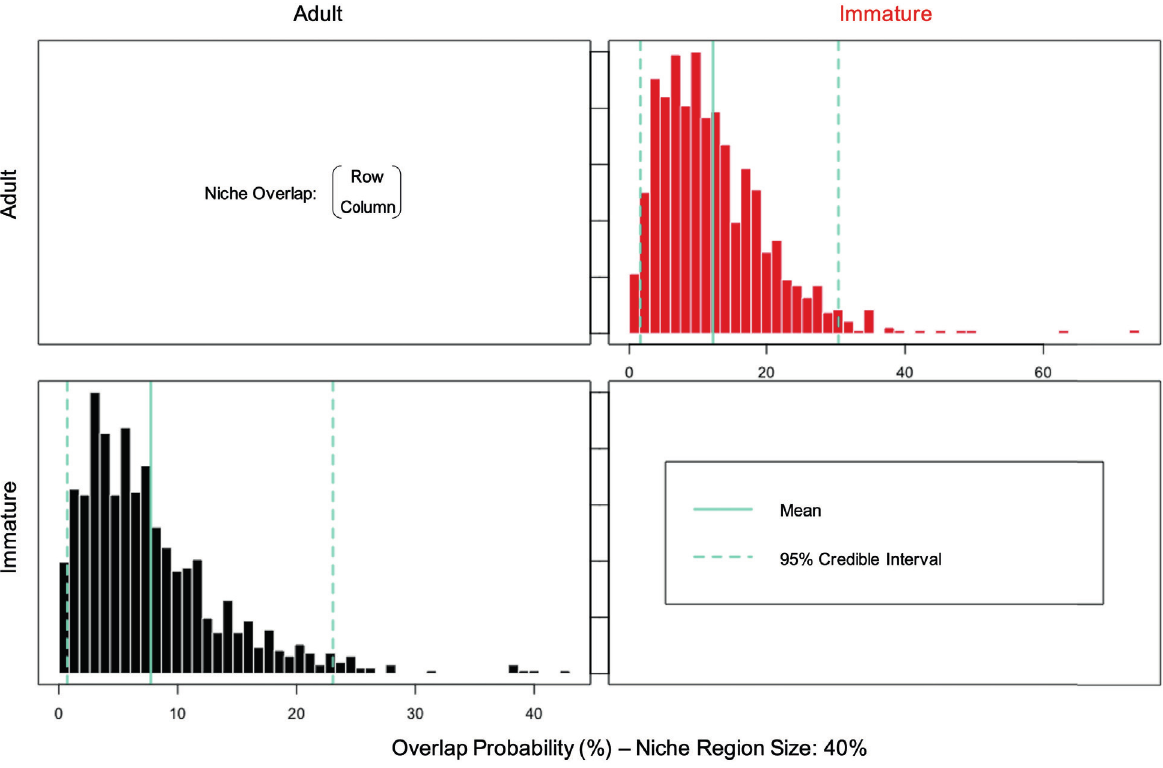
Figure 4. Posterior distribution of percentage overlap of 40% niche regions between Adult and Immature populations of Serrasalmus marginatus . Niche overlap is defi ned as the probability that an individual from one category (rows) is found within the niche region of the other category